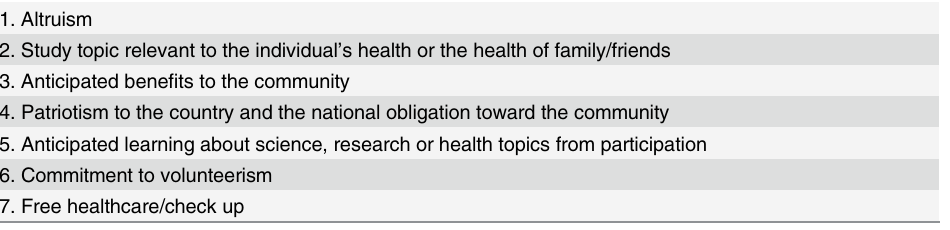
Table 3. Reasons Identified by Participants for Participating in Clinical Research.